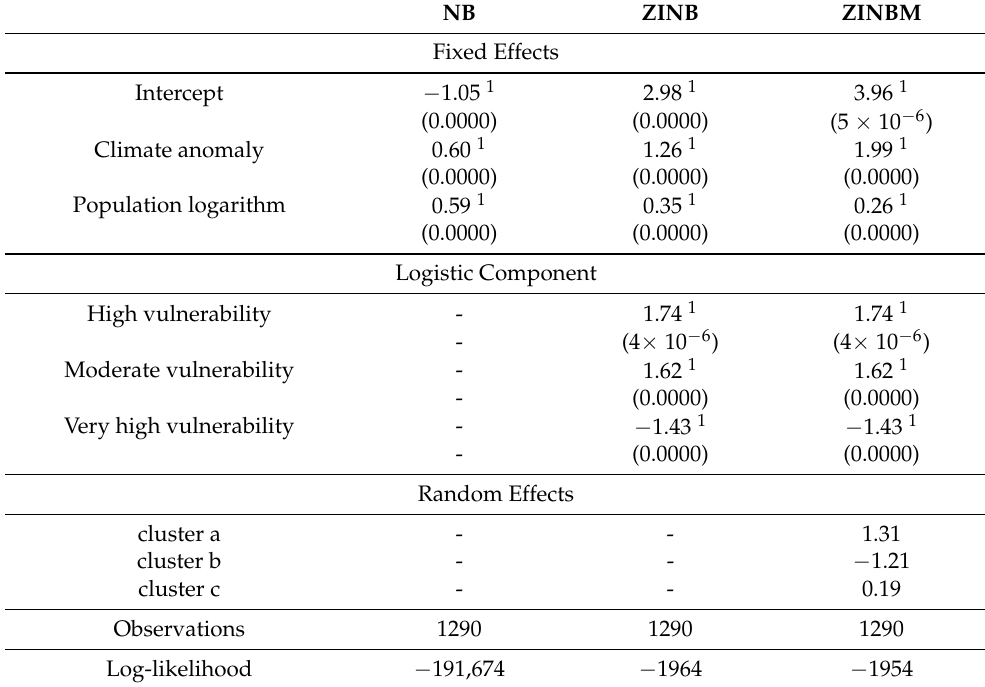
Table 5. Estimations of NB, ZINB, and